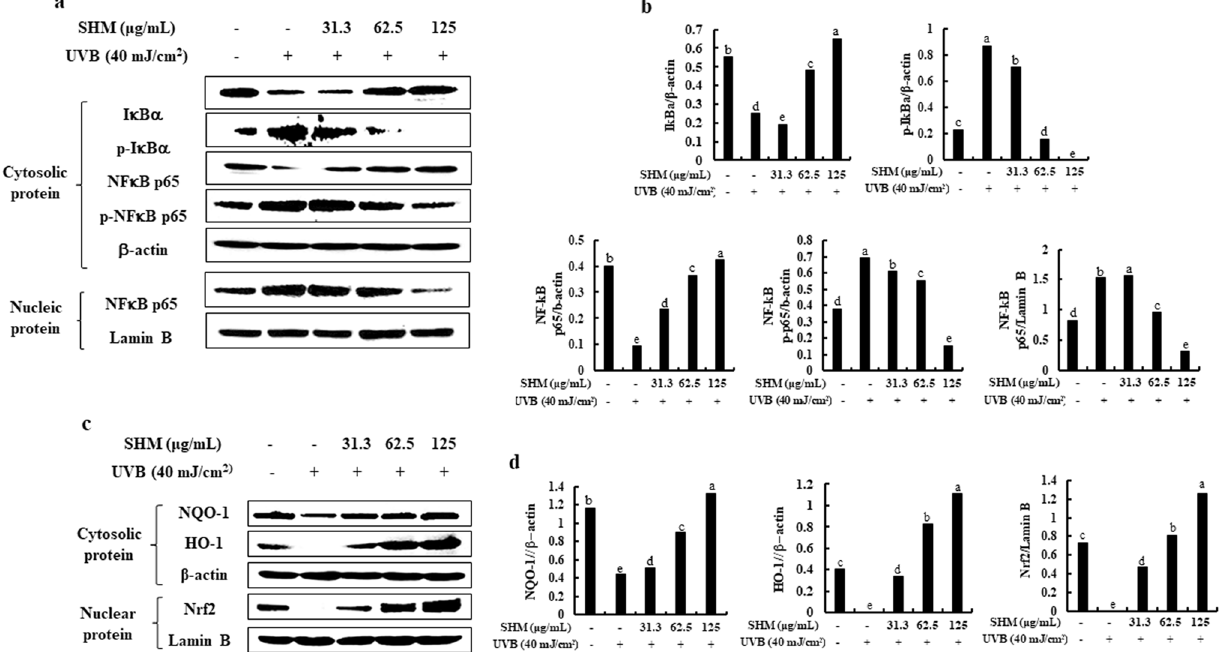
Figure 3. Effect of SHM on the activation of NF-κB and the reduction of Nrf2/HO-1 in UVB-exposed human keratinocytes. ( a ) NF-κB-related protein expression levels in SHM-pretreated and UVB-exposed human keratinocytes. ( c ) Nrf2/HO-1-related protein expression levels in SHM-pretreated and UVB-exposed human keratinocytes. ( b , d ) The density ratio of protein expression was analyzed via Image J software each in comparison to β-actin or Lamin B. Values are expressed as means ± SE of triplicate determinants (n = 3). a–e Bars with different letters for each molecule are significantly different (P <